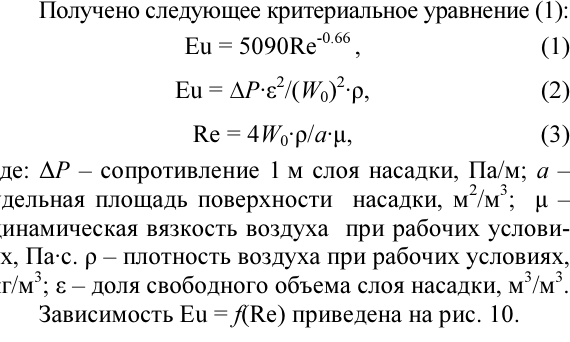
Fig. 8. The schedule of dependence of hydraulic resis- tance of a layer packing of rings Raschig dP / H from speed of air W 0